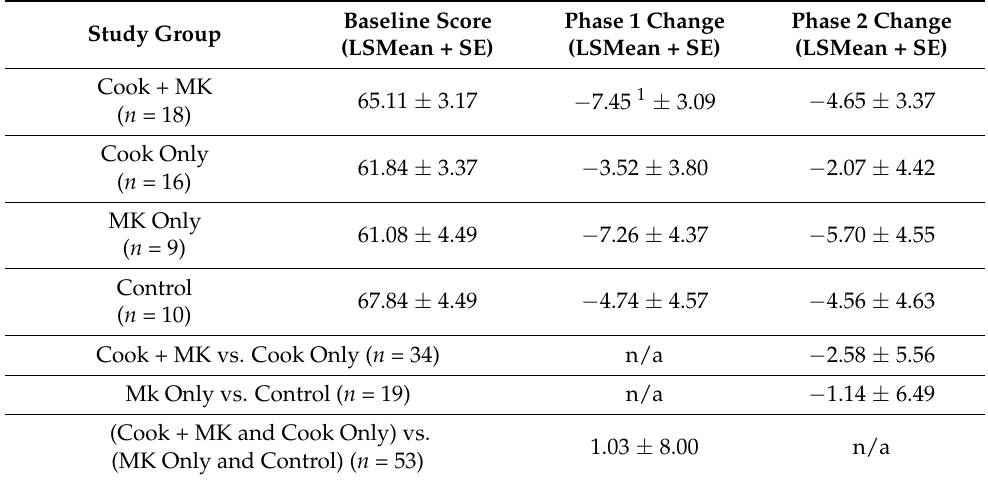
Table 3. Mean baseline Healthy Eating Index (HEI) scores and score changes at phase 1 and phase